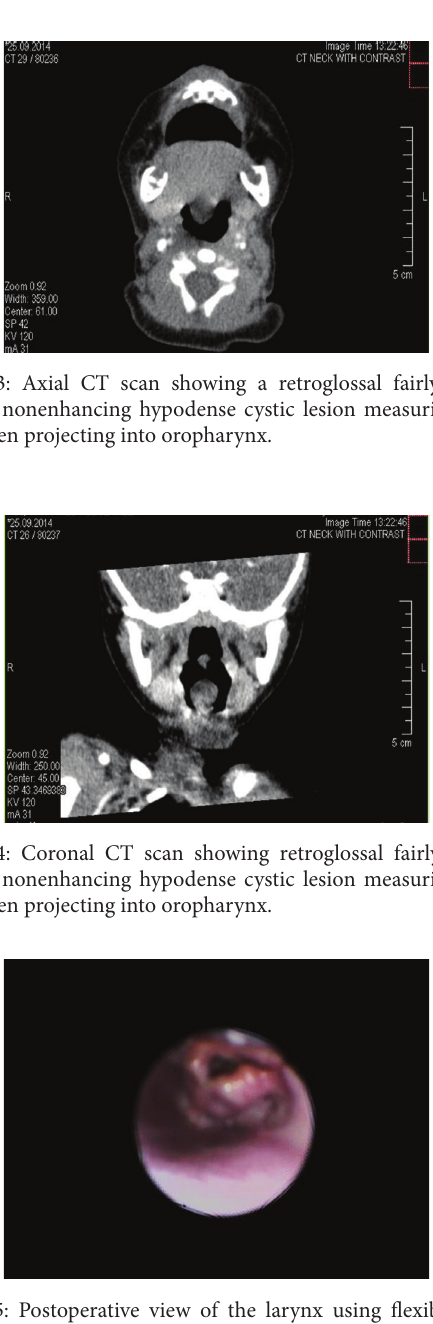
Figure 5: Postoperative view of the larynx using flexible upper endoscopy showing complete resolution of the cyst and patent